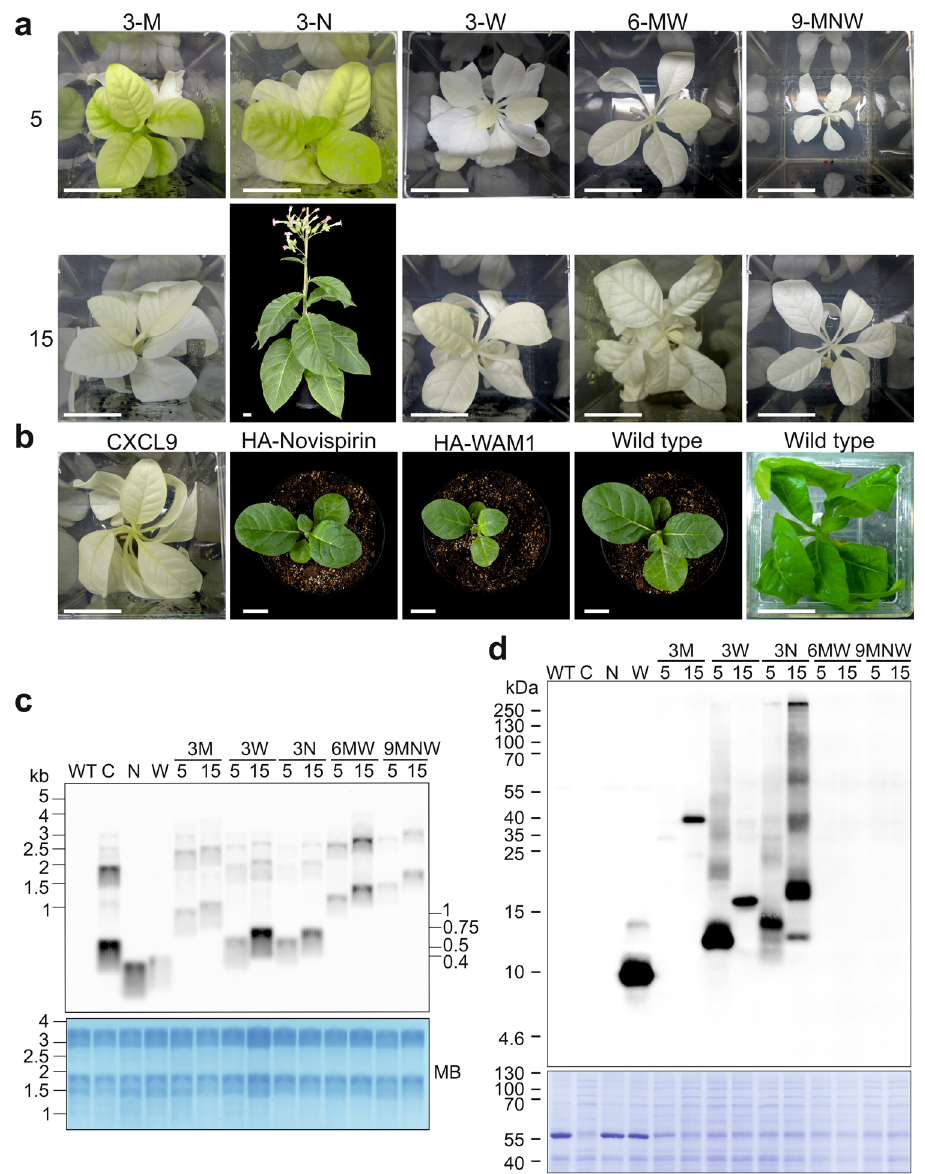
Fig. 2 | Phenotypes of transplastomic plants that constitutively express AMPs and fAMPs and analysis of transgene expression. a Plant phenotypes of trans- plastomic lines expressing fAMP combinations of 3, 6 or 9 different AMPs con- nected by 5 or 15 amino acid linkers (length of linker is indicated on the left of the pictures; cf.Supplementary Table 1, Supplementary Data1 and 2). Plants incapable